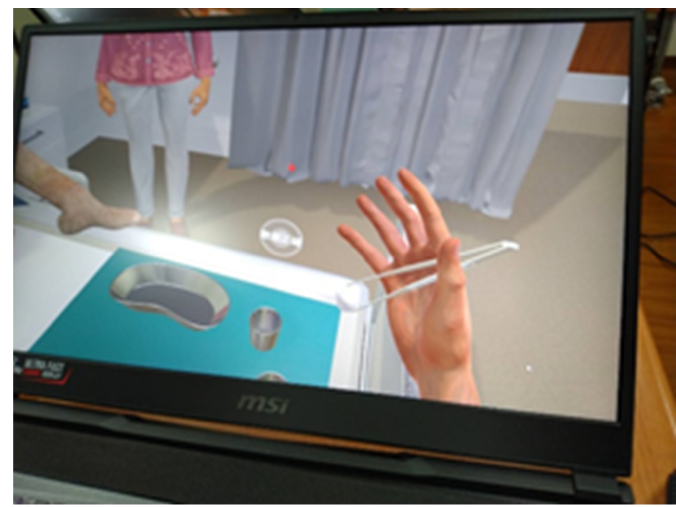
Figure 2. The participant’s